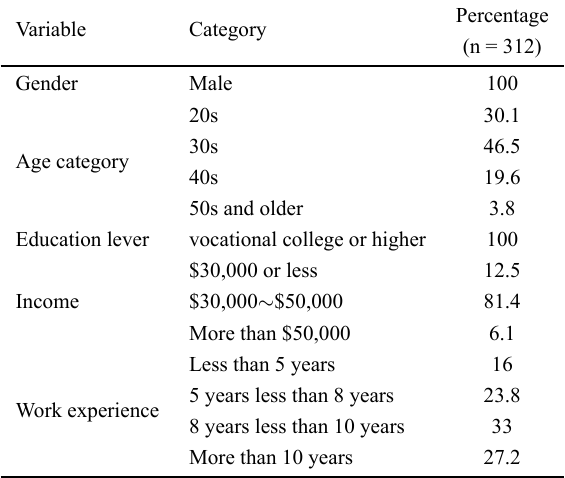
Table 1. Demographic